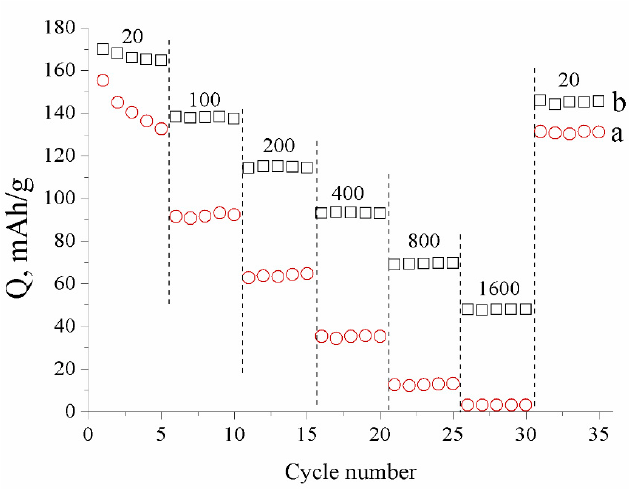
Figure 6. Cycling performance of the LTO/5%G_157M ( a ) and LTO/5%CB ( b ) composites (electrodes were prepared without addition of carbon black Timcal). The current densities (mA / g) are shown in the Figure.